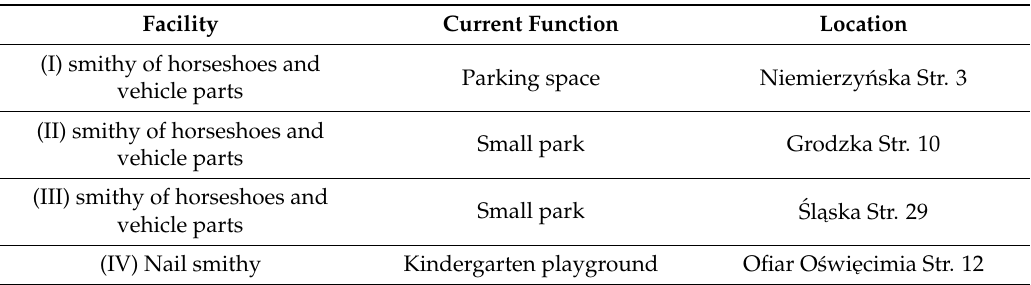
Table 1. Selected research